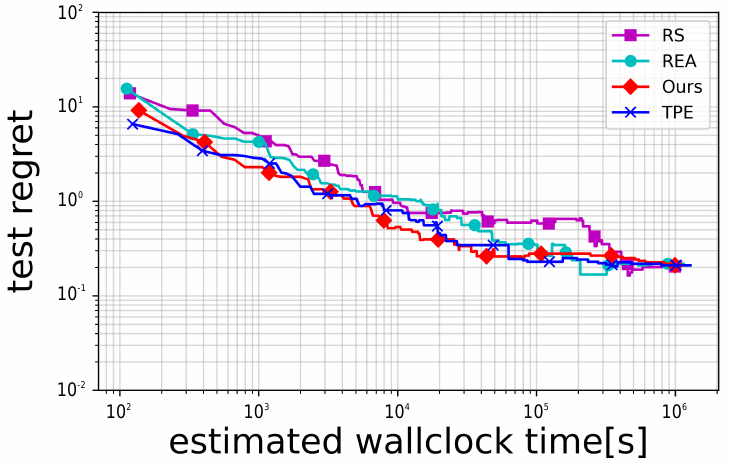
Figure 5. Compare the mean test accuracy along with error bars on NAS-Bench-201. Figure 5. Comparison of the mean test accuracy along with error bars on NAS-Bench-201.